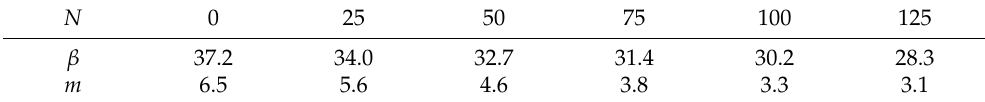
Table 3. Double parameter values of Weibull